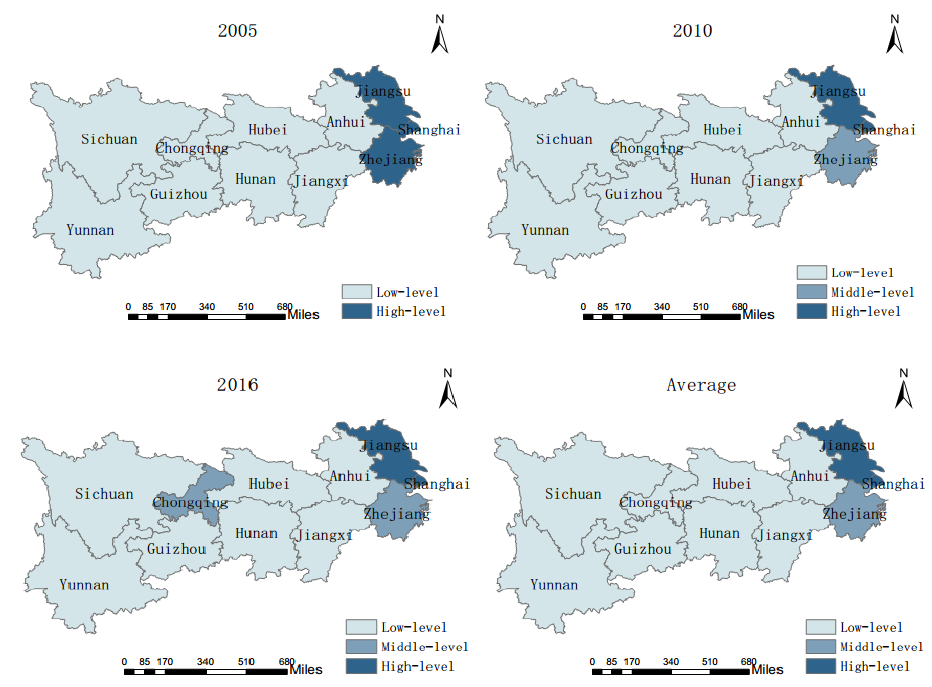
Figure 3. Spatial distribution of comprehensive scores of CERC of the YREB.